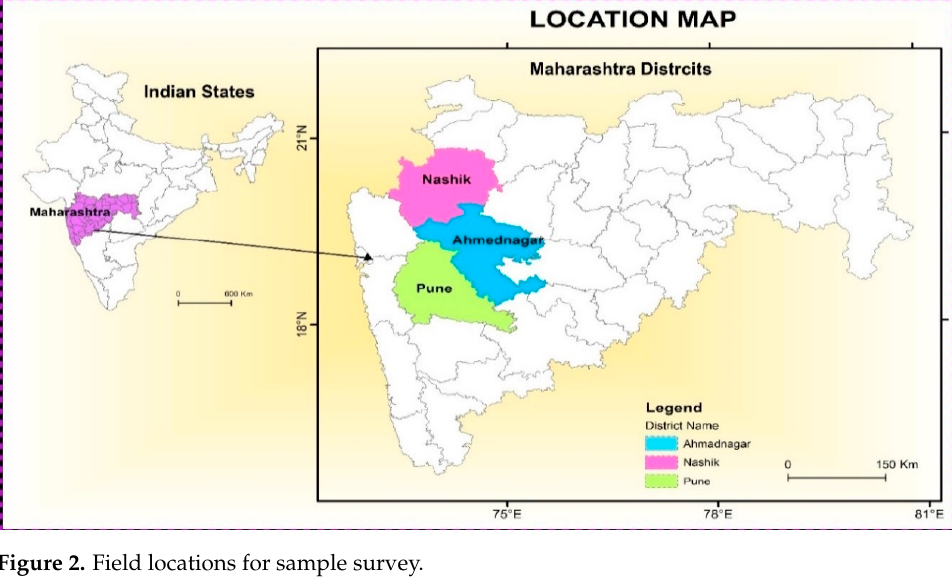
Electronics 2022 , 11 , x FOR PEER REVIEW Figure 2. Field locations for sample survey. Figure 2. Field locations for sample survey. Table 3. List of QS factors and variables.